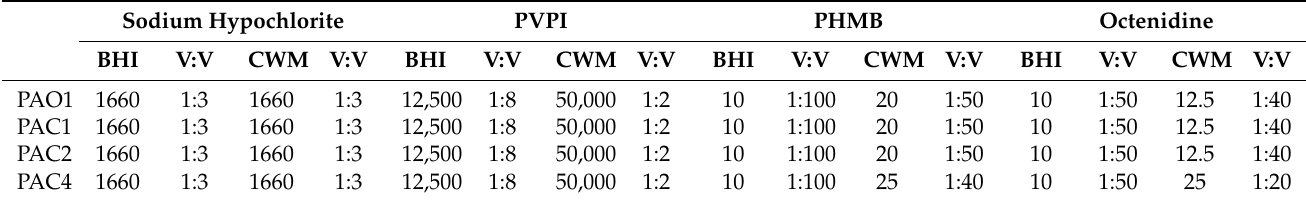
Table 2. Antiseptic concentrations (in 10 − 3 g · L − 1 ) and dilution ratios (in V:V) needed to obtain a 10-log reduction in the living bacterial load of P. aeruginosa strains (the reference strain PAO1 and three clinical strains, PAC1, PAC2 and PAC4) cultivated in two media, BHI and CWM.